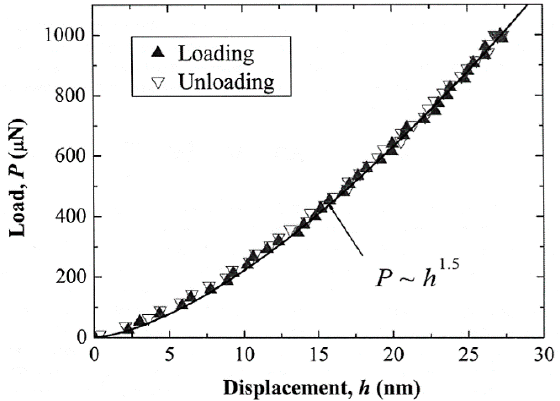
Figure 2. Continuous load/unload curve for nanoindentation of a (0001) sapphire crystal surface [7].